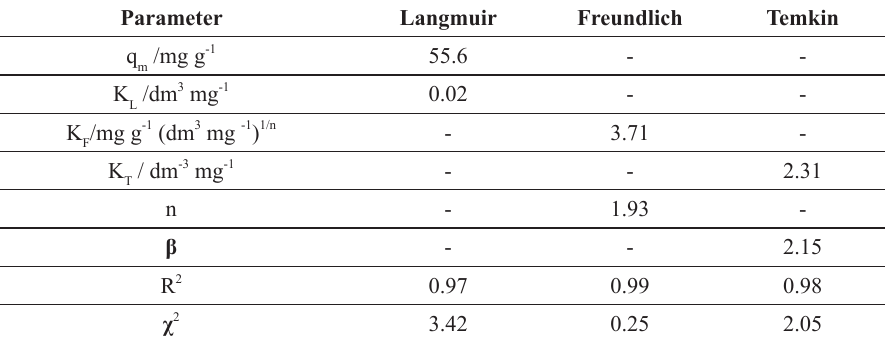
Parameter obtained by non-linear fit of the isotherm